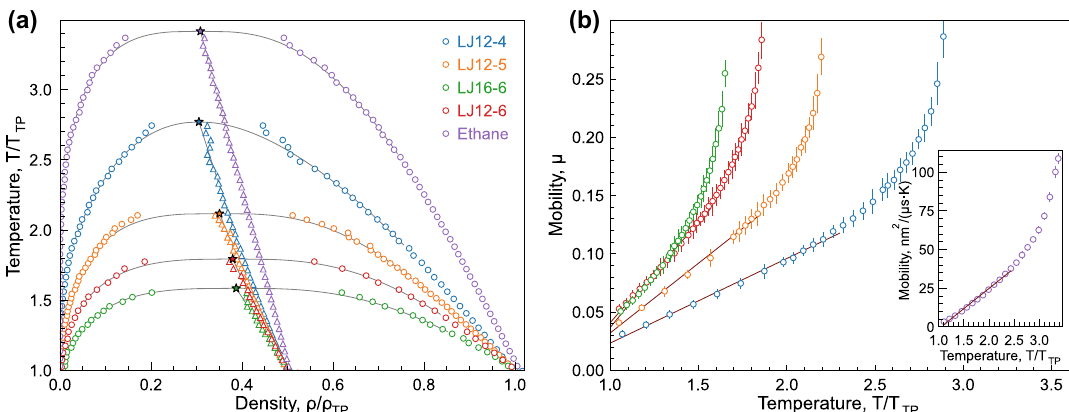
Figure 2. Particle mobility in liquid on gas-liquid binodals: ( a ) liquid–gas binodals of the considered systems. The binodals were calculated by the two-phases simulation method described in Materials and methods section. The color symbol denote the calculated binodals, the triangles denote the median points. The solid gray lines show the temperature range used in approximation and determination of parameters in Eq. (7). ( b ) Temperature dependence of particle mobility in liquid under coexistence with a gas. Straight lines correspond to linear approximations for the mobility. The calculated mobility of ethane is shown as inset in panel ( b ).